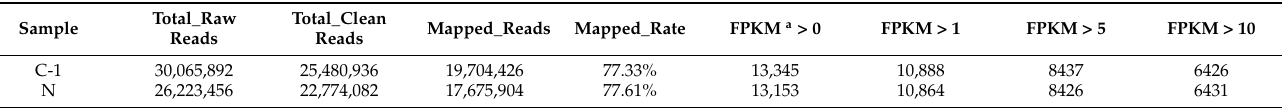
Table 2. Summary of read quality and mapping results of RNA-Sequencing (RNA-Seq).